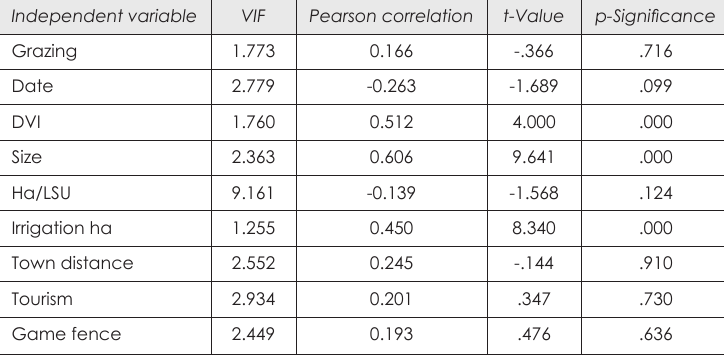
Model 1 regression correlations and